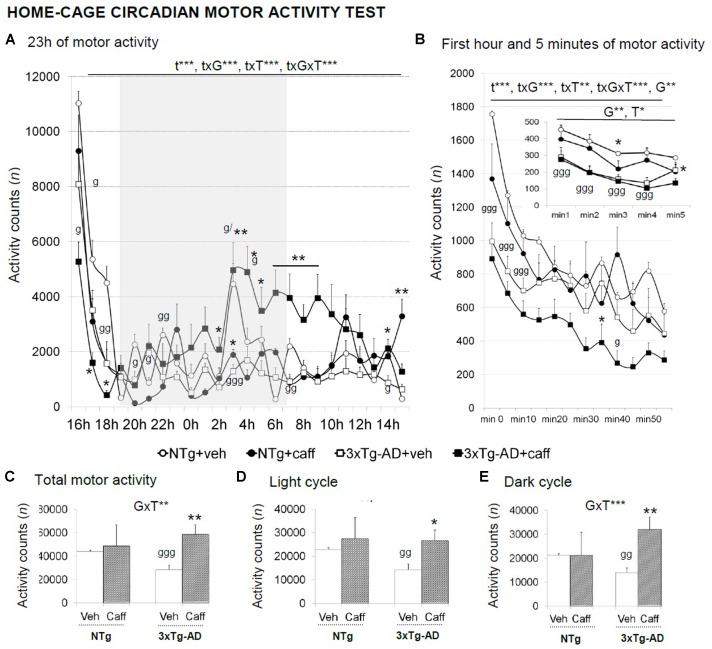
Effects of chronic caffeine treatment in the home-cage on circadian motor activity in NTg and 3xTg-AD mice at 13 months of age. Data are expressed by mean ± SEM or percentage (%). Veh, vehicle: Caff, caffeine. The vertical axis shows motor activity counts during the time intervals of the 23 h continuous recording (A), 1-min intervals (right-hand graphs) during a period of l h (B), or 5-min intervals (inset of B). Total activity counts during the 23 h (C), the light (D), and the dark (E) cycles are detailed. Data are expressed by mean ± SEM. The text at the top of each graph refers to the p-values of the 2 × 2 ANOVA: G, genotype effect; GxT, genotype × treatment interaction; t, time effect; txG, time × genotype interaction; txT, time × treatment interaction; ∗p < 0.05, ∗∗p < 0.01, ∗∗∗p < 0.001. Post hoc comparisons are shown in the graphs as: g p < 0.05, gg p < 0.01, ggg p < 0.00l vs. the corresponding NTg group; ∗p < 0.05 vs. the corresponding non-treated group.